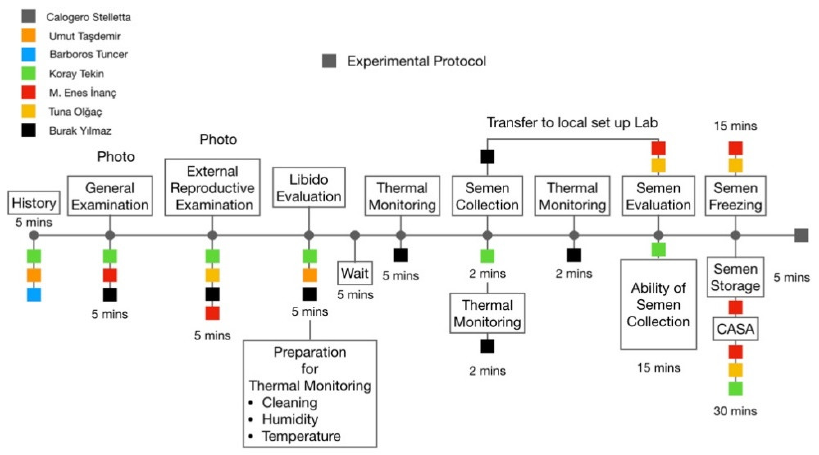
Figure 1. General experimental protocol across time.